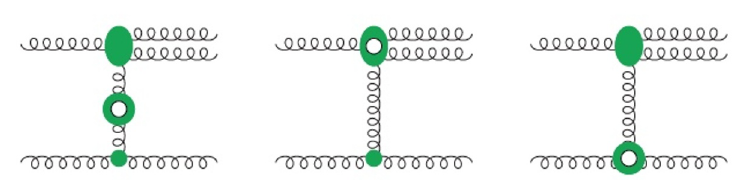
Figure 6 . Factorisation of the one-loop five-gluon amplitude in NMRK. The three diagrams repre- sent the three terms in eq. (2.20). The pierced blobs represent ( a ) the one-loop Regge trajectory and the one-loop corrections to the impact factor for the emission of ( b ) two gluons and ( c ) one